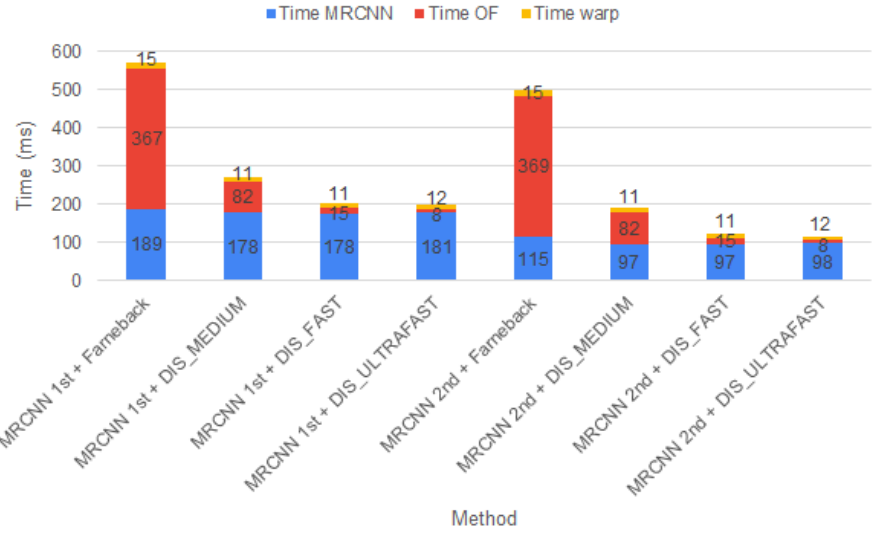
Figure 9. Mask RCNN, Optical Flow and Warp time, Cityscapes dataset [2], Colab